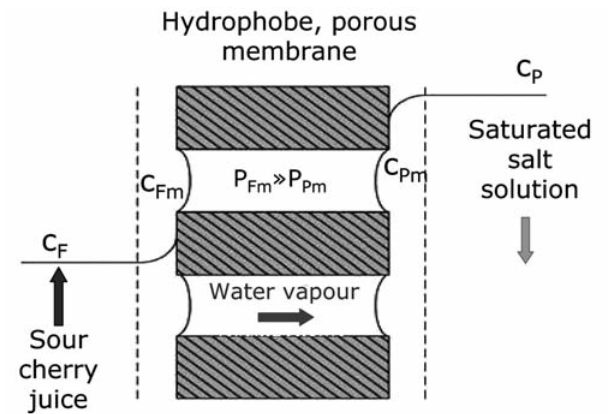
Figure 1. Flow sheet of osmotic distillation